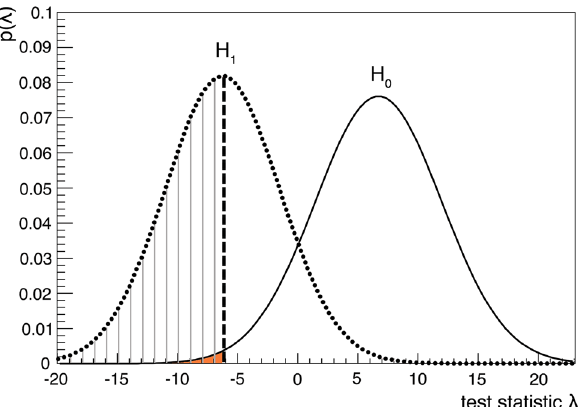
Fig. 3 Measured muon event density as a function of the angular dis- tance δ from the Moon. Data histogram is shown with statistical errors; the smooth line is the best fit according to Eq. (4); the shaded area corresponds to the apparent radius of the Moon (0 . 26 ◦